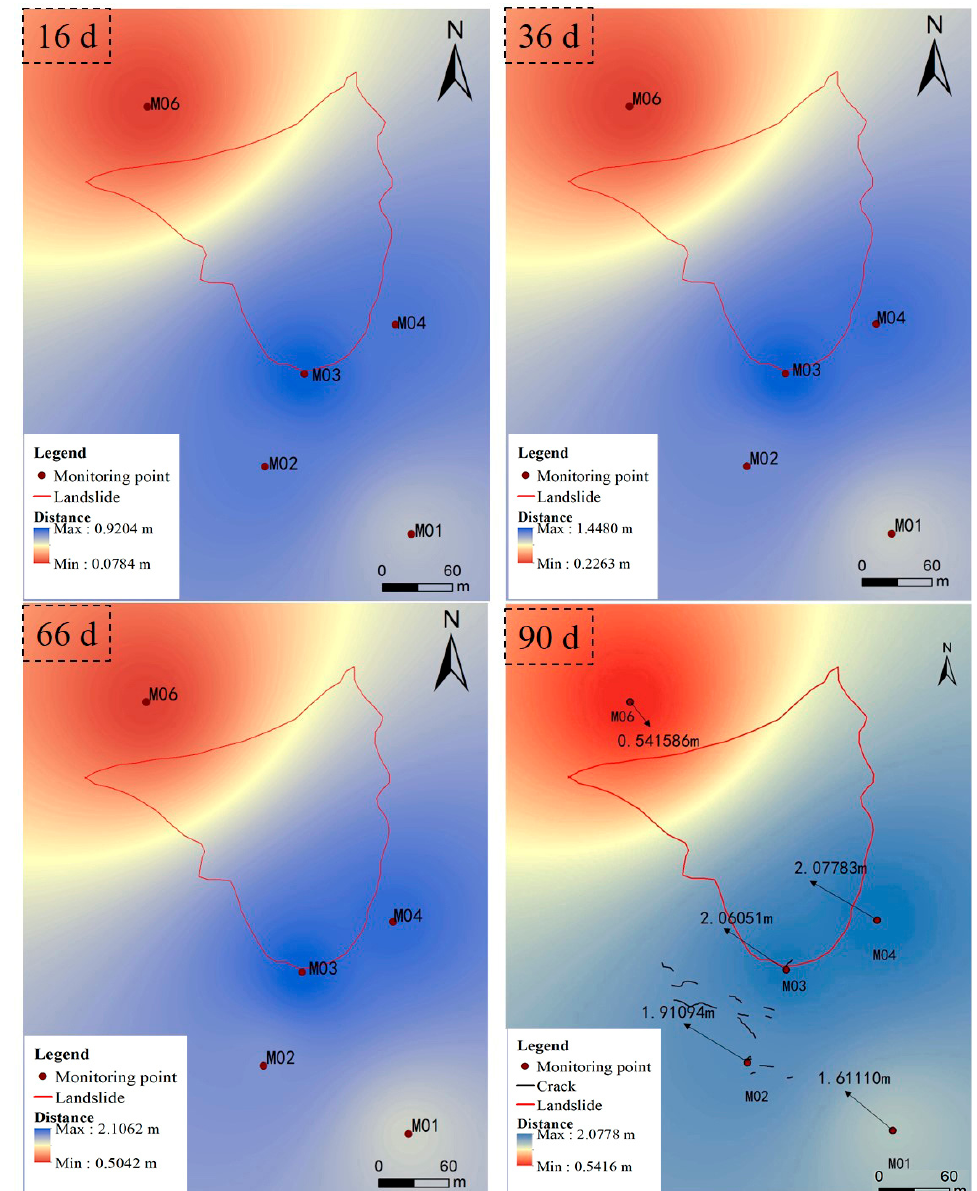
Figure 11. Displacement field of the Luhu village slope body.